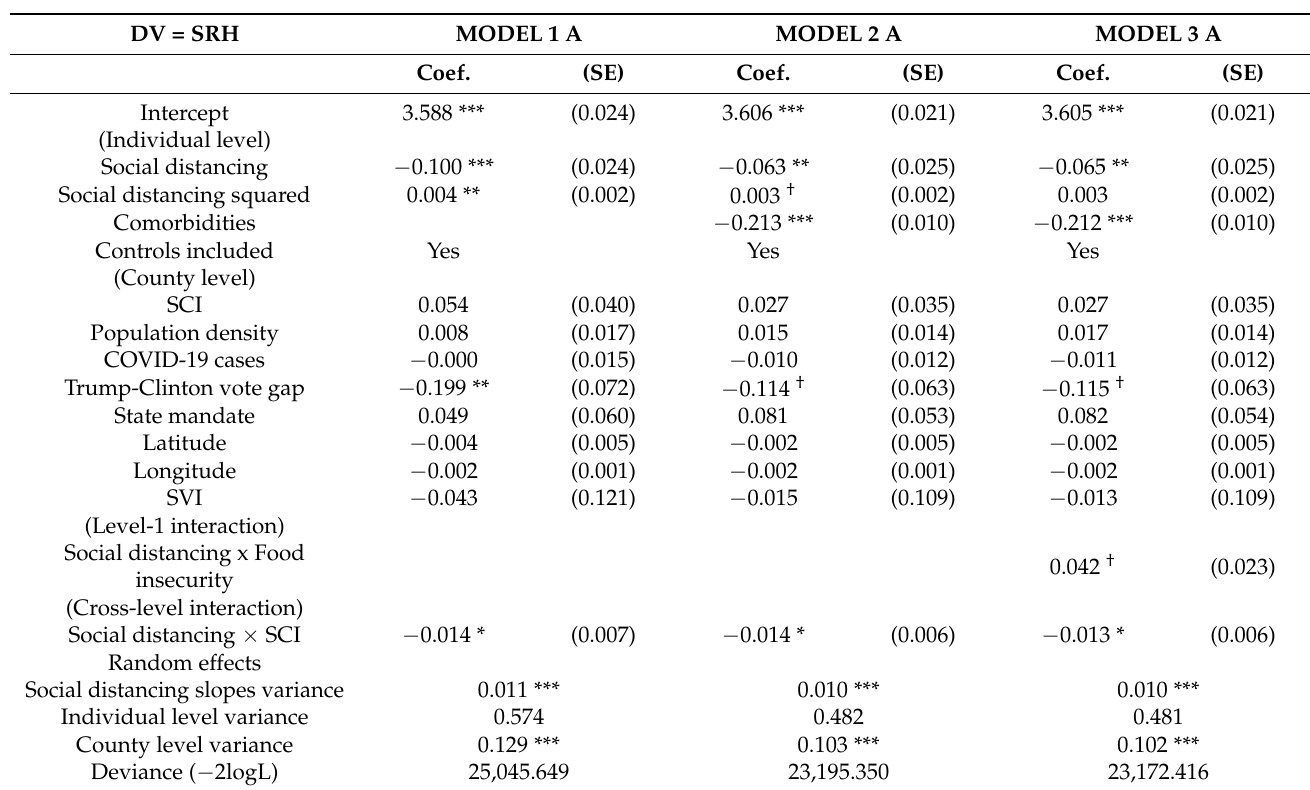
Table 3. Results from Multilevel Analysis Estimating the Cross-Level Interaction